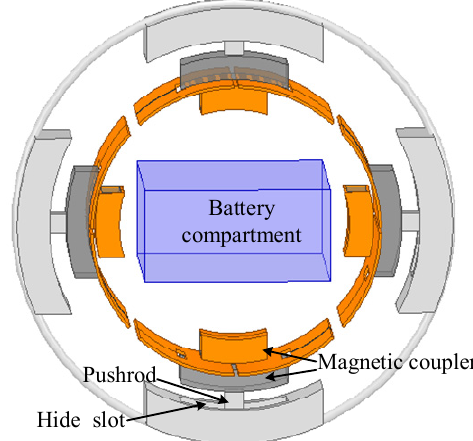
Figure 7. Diagram of the clamping device.